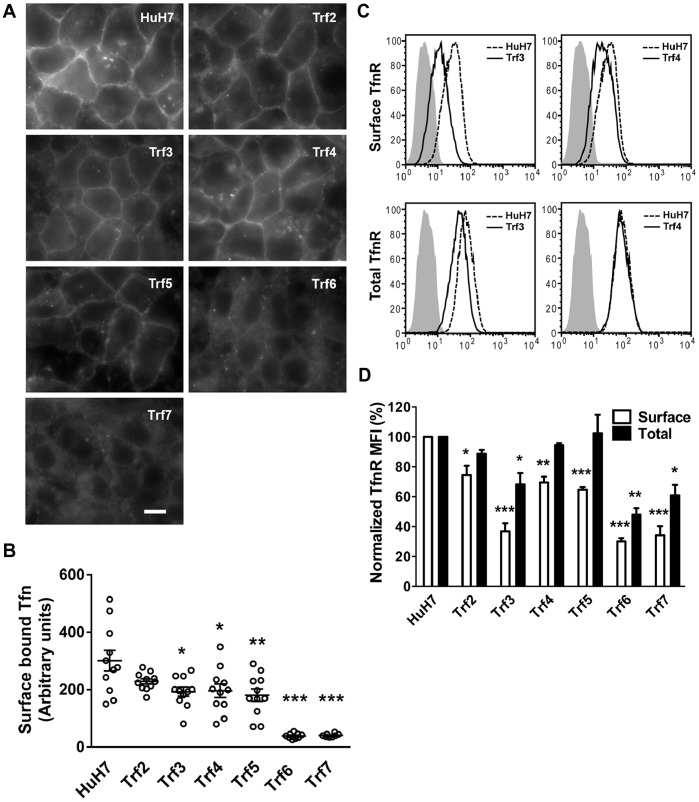
Surface Tfn binding and TfnR distribution.(A) Cells were washed and incubated with Alexa Fluor 488-labeled Tfn on ice for 30 min prior to fixation. Fixed cells were imaged using a widefield microscope. Scale bar: 10 µm. (B) The mean fluorescence of surface Tfn was measured by NIH ImageJ software and is presented as mean ± SEM (n = 11). The data are representative of two independent experiments. (C) Total and cell surface TfnR expression were analyzed by flow cytometry of fixed cells incubated with either FITC-conjugated anti-TfnR antibody or isotype control, with or without cell permeabilization. Total and surface TfnR profiles for Trf3 and Trf4 are shown with a solid line and HuH7 TfnR profiles are shown with a dashed line. The data are representative of three experiments. (D) The histogram represents cell surface or total TfnR normalized to HuH7 cells and are expressed as mean ± SEM, n = 3. Statistical analysis was performed using a Student’s t-test. *p<0.05, **p<0.01, ***p<0.001.